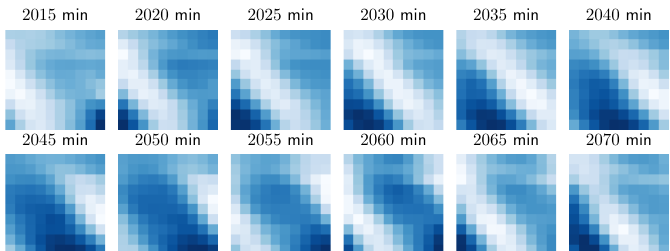
Figure 8. An hour of wind speeds used from the WIND dataset. The minutes are counted from the start of the dataset